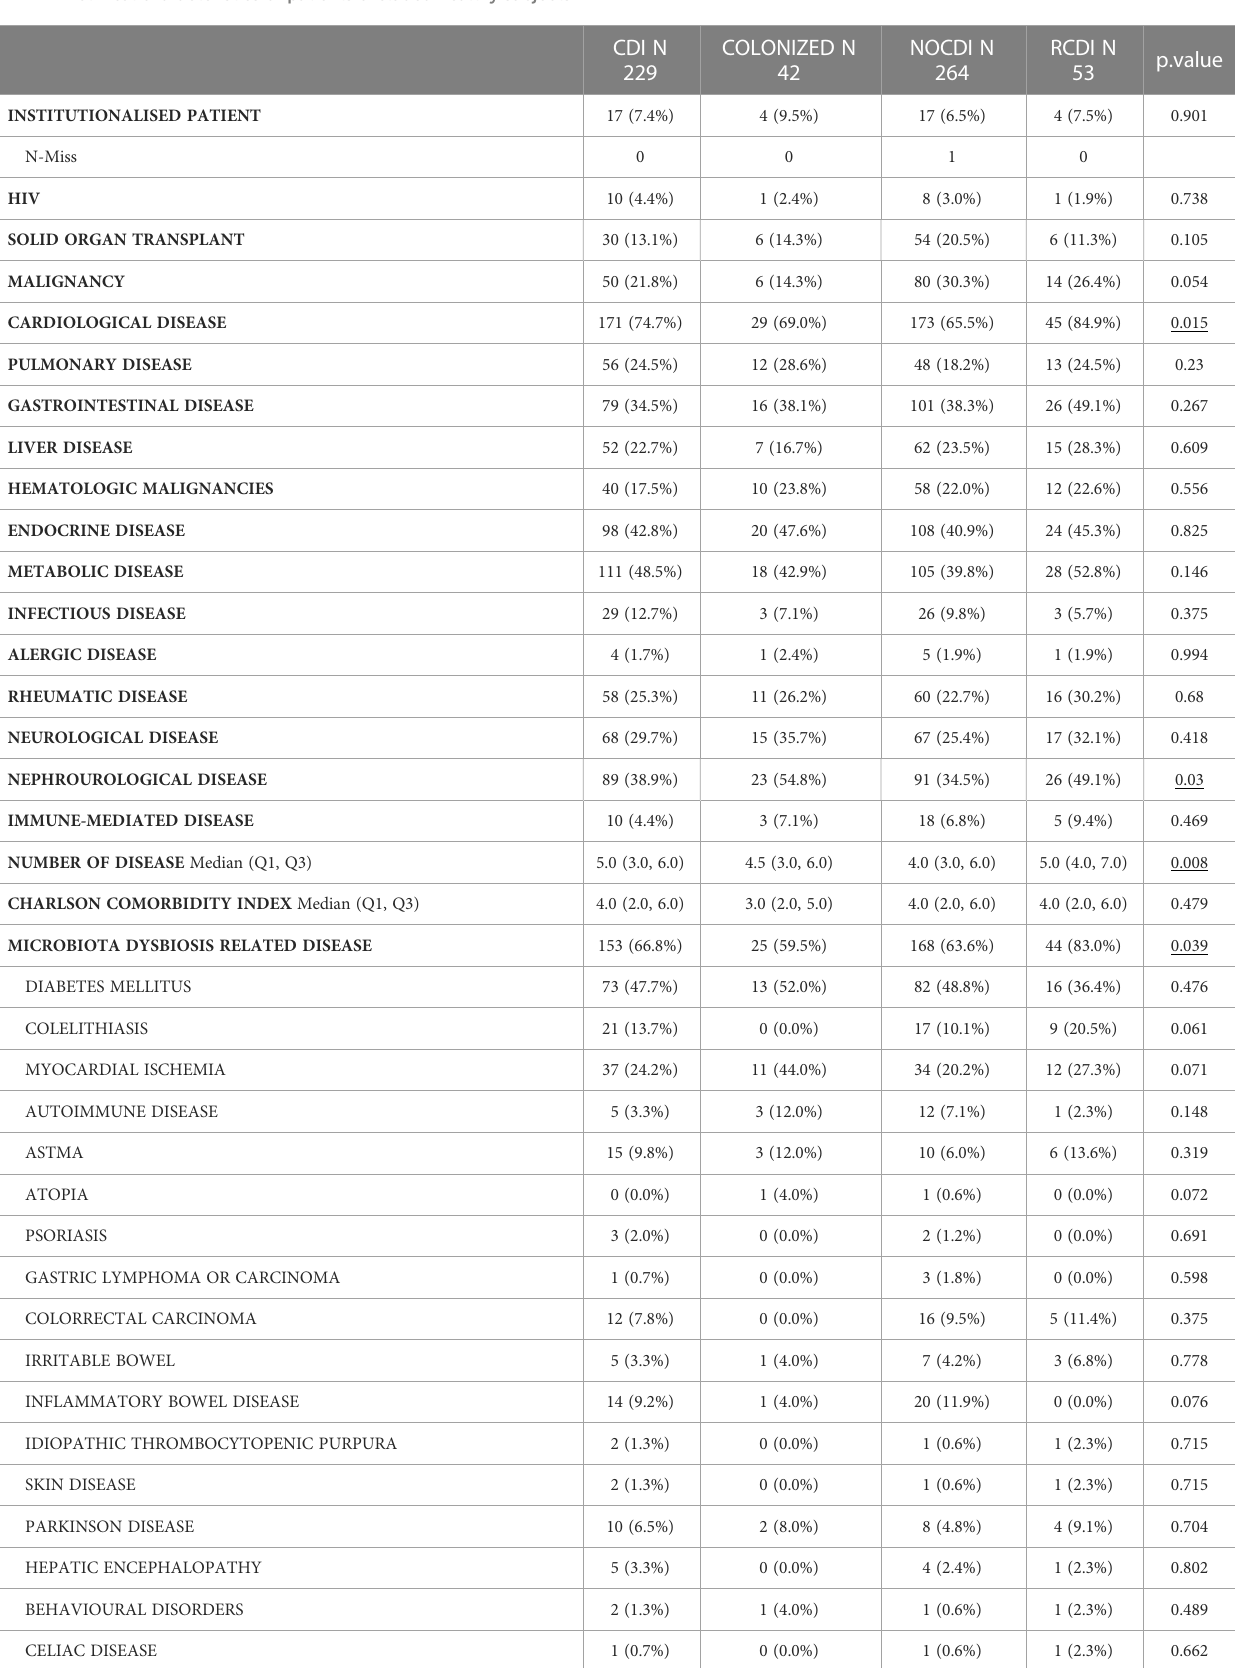
TABLE 1 Clinical characteristics of patients excluded healthy